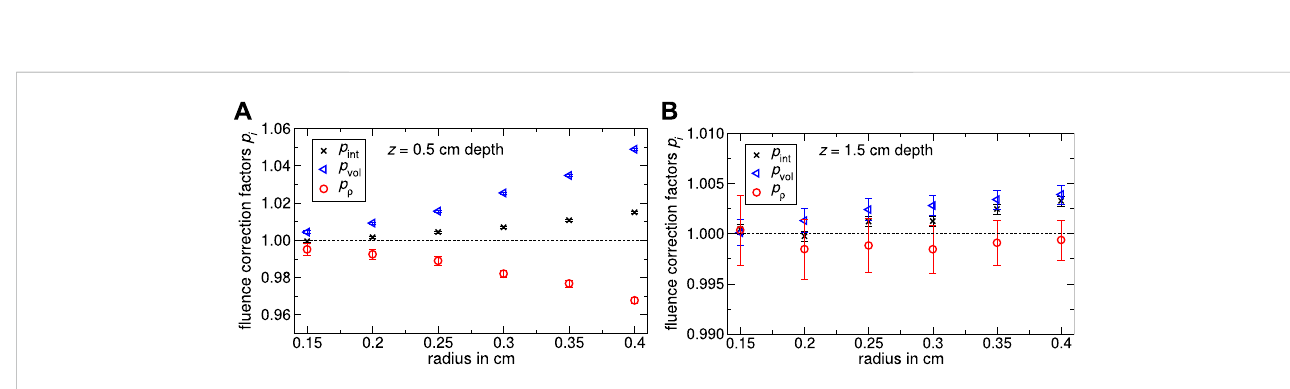
FIGURE 7 The Monte Carlo calculated internal fl uence correction factor p int , the volume-averaging correction factor p vol and the density correction factor p ρ for thecavitywithalengthof0.48 cmanddifferentradiiin (A) 0.5 cmand (B) 1.5 cmwaterdepth.Theuncertaintyvarieslikelyby0.2%for p int ,respectively p vol and 0.4% for p ρ